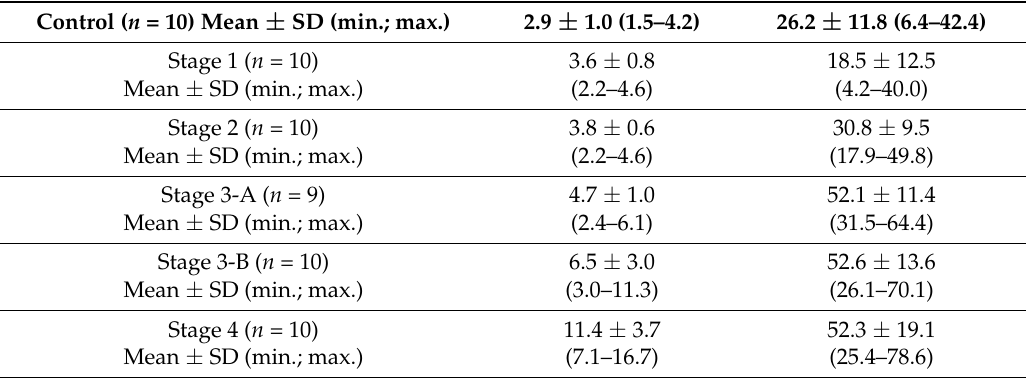
Table 2. Mean, standard deviation (SD), minimum (min.) and maximum (max.) of serum concentrations of phosphorus (sP; mg/dL) and urinary fractional excretion of phosphorus (uFEP; %) in control dogs and in dogs with chronic kidney disease (Stages 1, 2, 3-A, 3-B and 4). Control ( n = 10) Mean ± SD (min.;